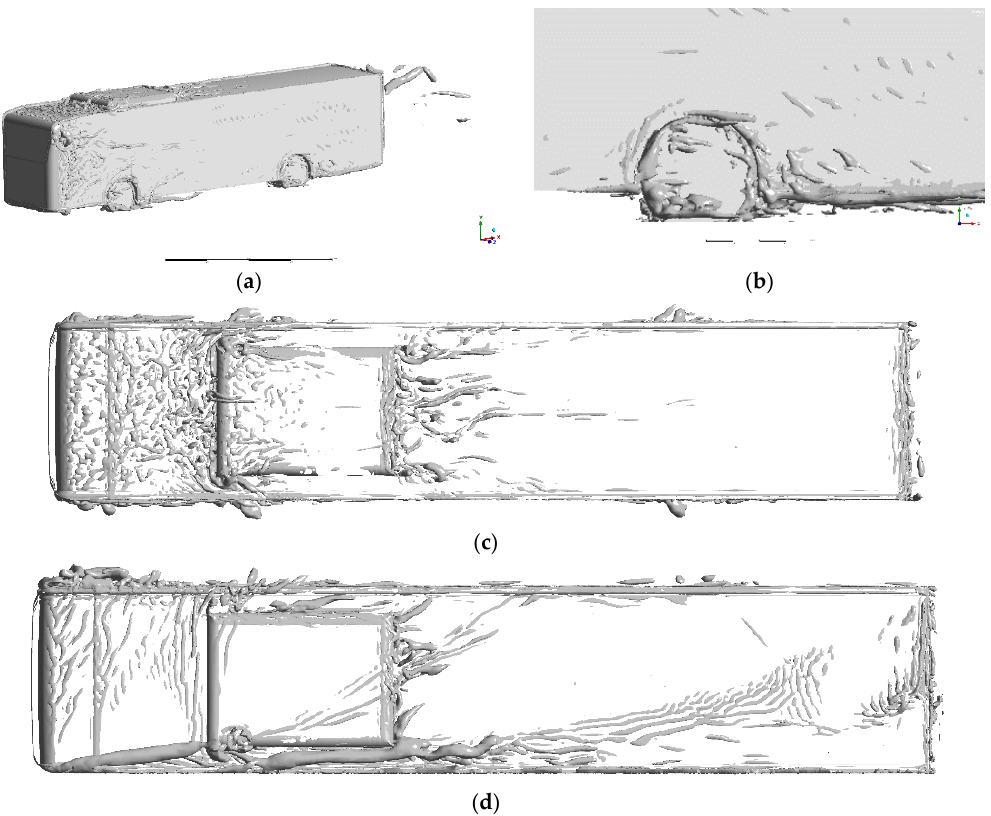
Figure 11. Q-criterion distribution on ( a ) the bus and ( b ) near wheel; ( c ) symmetrical flow; ( d ) asym- metrical flow.